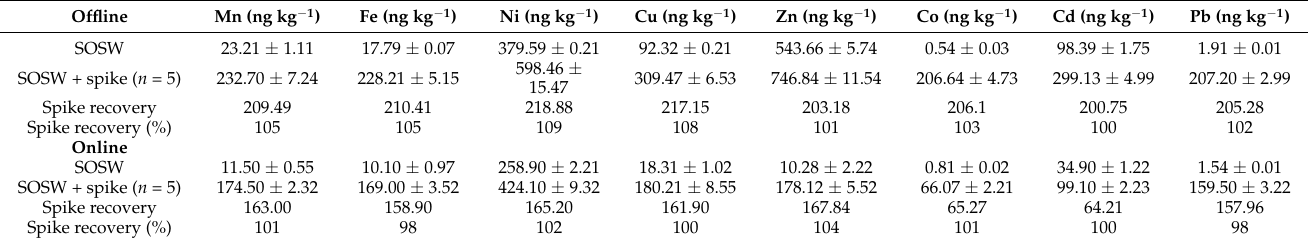
Table 6. Recoveries of trace elements on the sea FAST resin column.